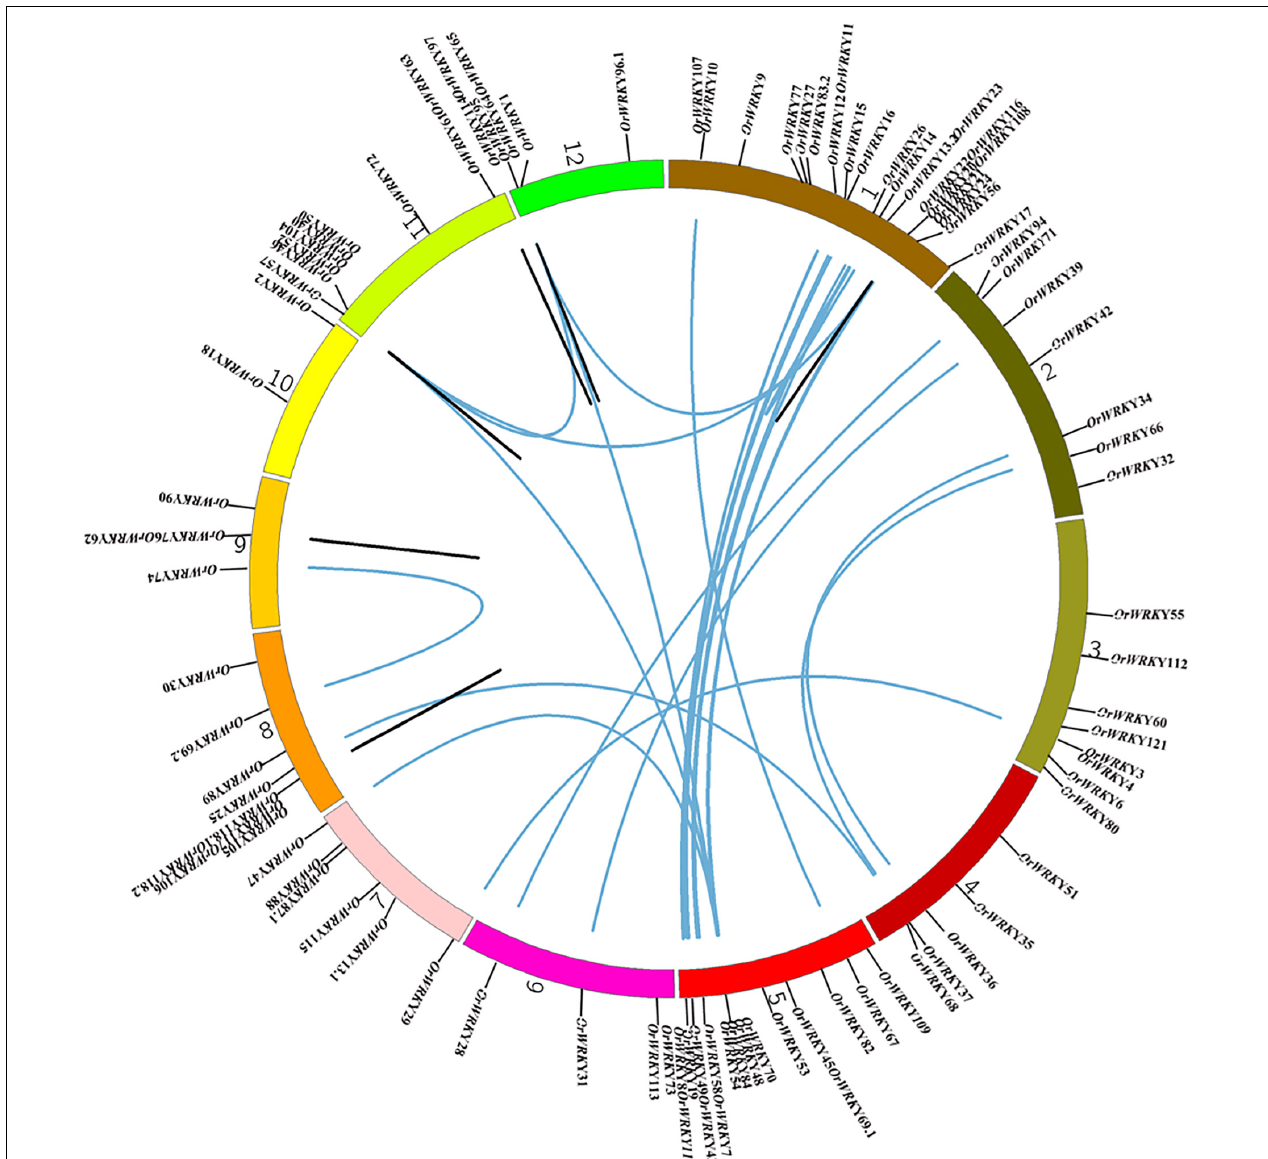
FIGURE 2 | Chromosome distribution and synteny analysis of OrWRKY genes. Chromosomes 1–12 are shown with different colors, and the approximate location of each OrWRKY gene is marked. Blue lines indicate duplicated OrWRKY genes, and black lines in the circle indicate tandemly duplicated